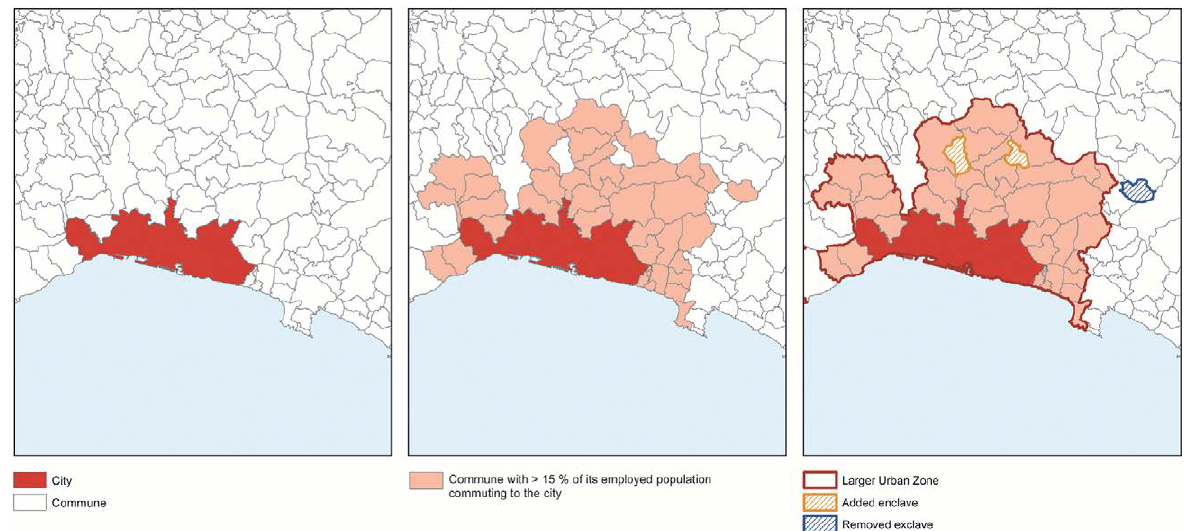
Fig. 4. Eurostat commuting zone